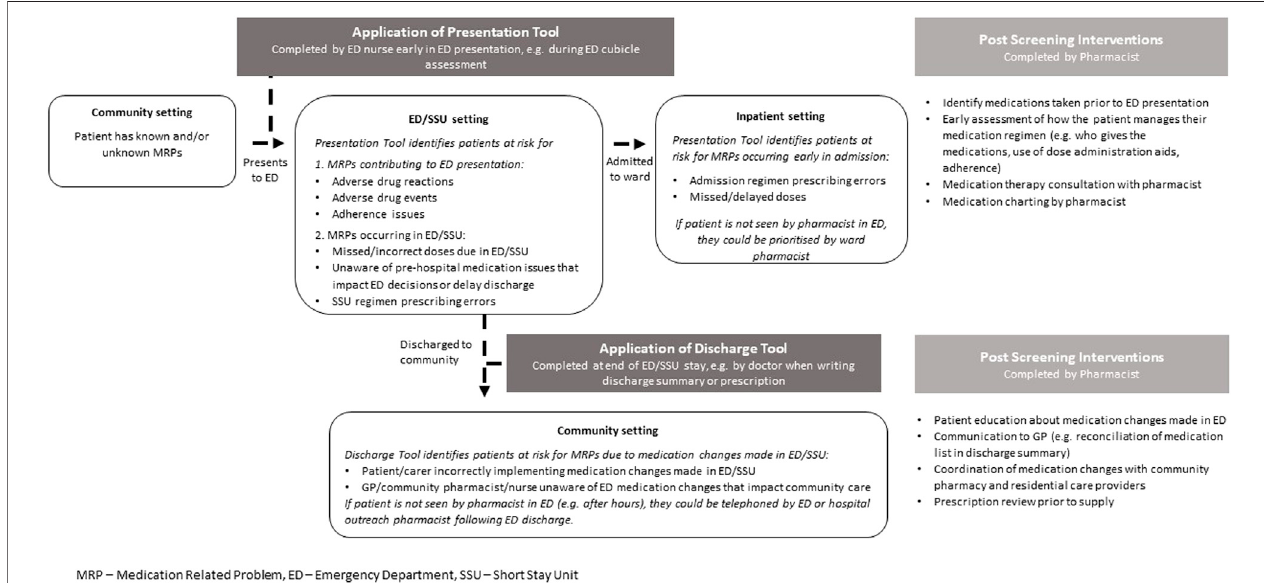
FIGURE 1 | Medication-related problems occurring across the ED patient